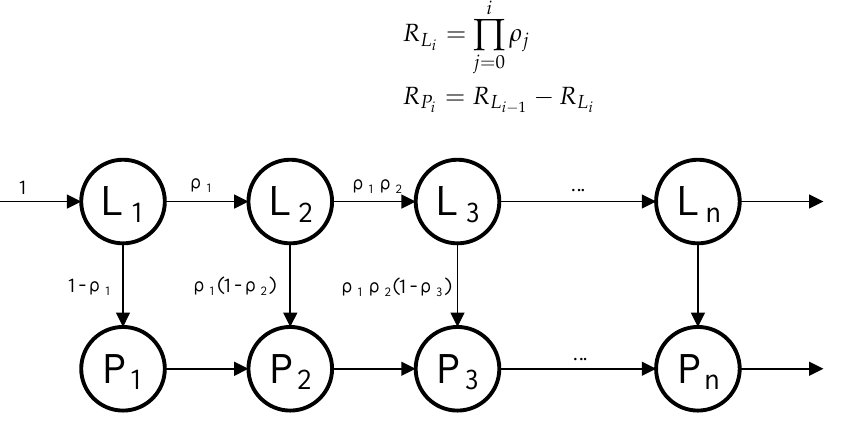
Figure 8. Traffic forwarding process